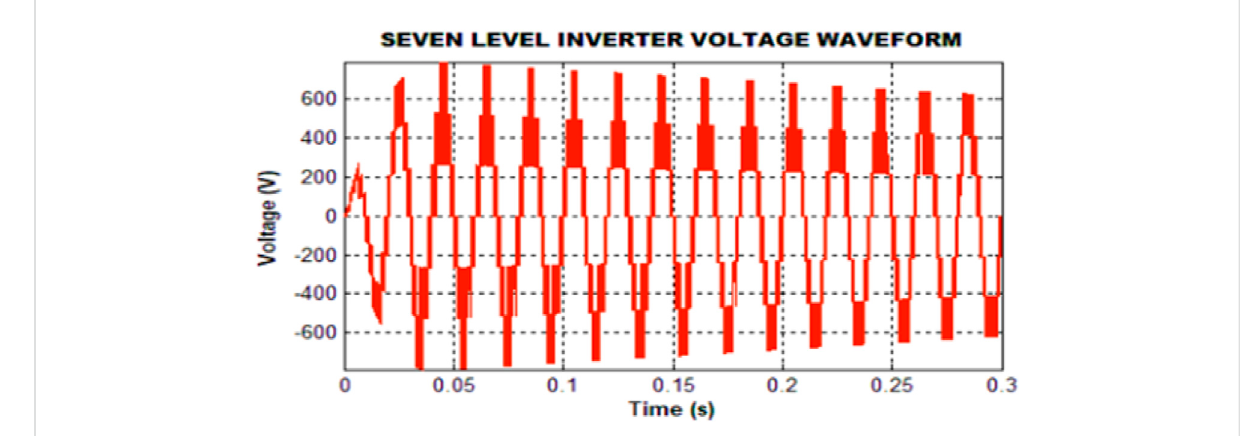
FIGURE 9 Voltage representation of the proposed 8S7L-TTB topology.